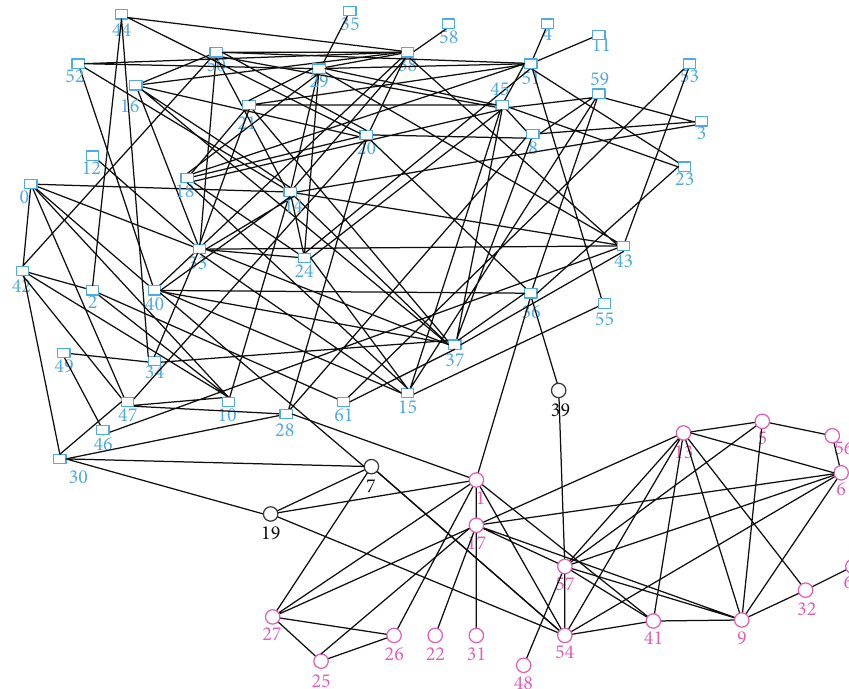
Figure 9: The community structure found by our algorithm in Dolphins interaction network.